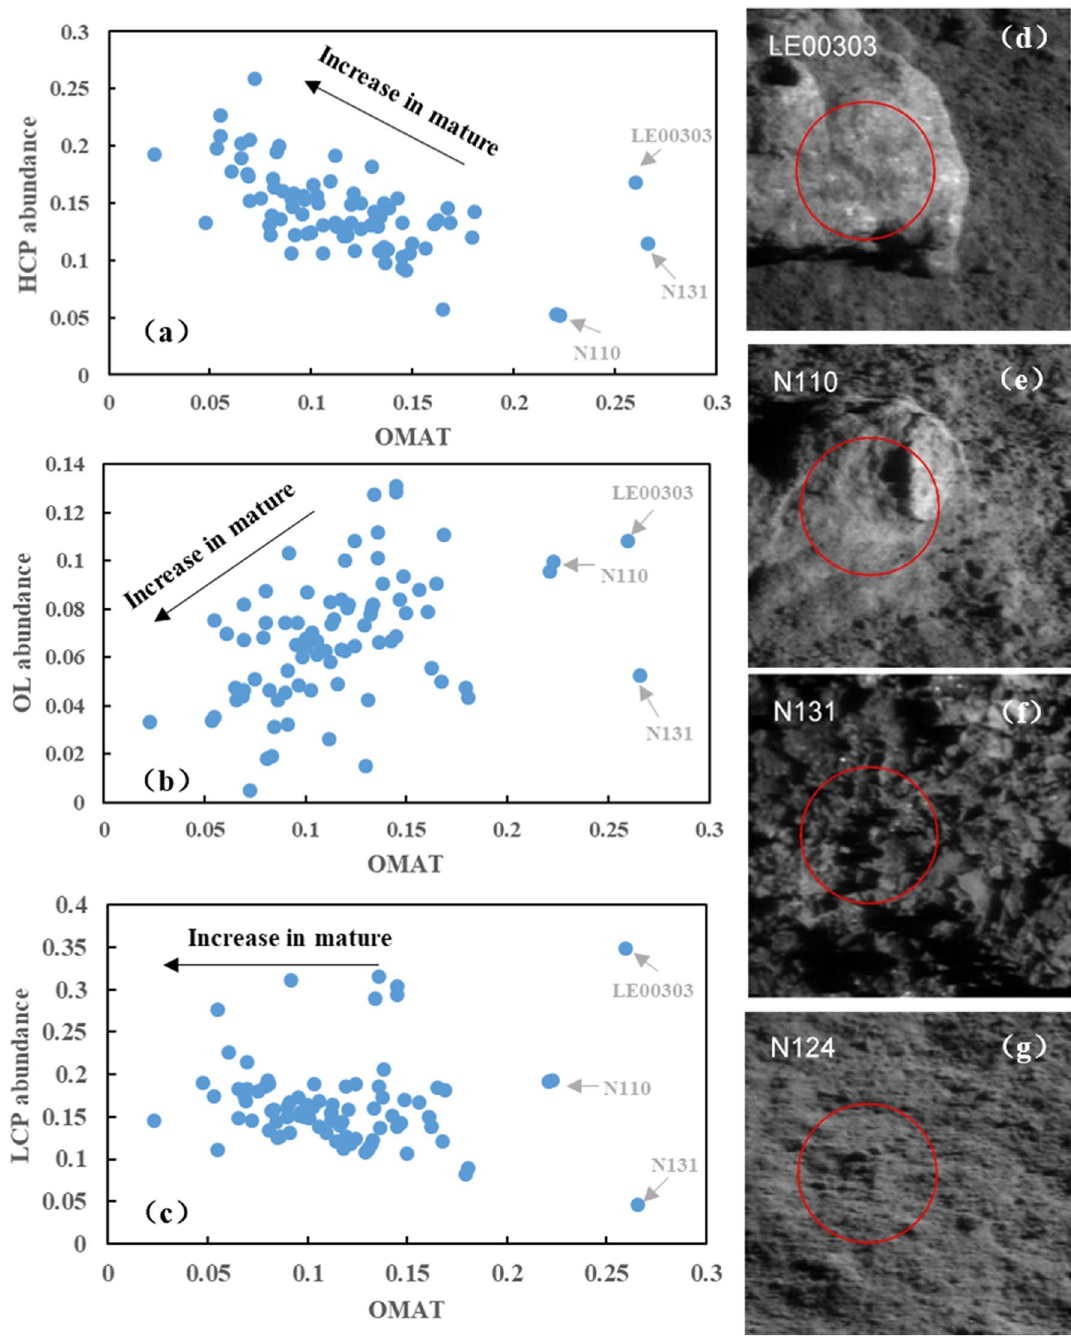
Figure 6. The relation between the OMAT and the main lunar minerals (HCP, LCP and OL). ( a – c ) are the scatterplots showing the relationship between the OMAT and the main lunar materials. ( d – g ) are the different type of lunar materials during the CE-4 routine path, ( d , e ) are the rock types, ( f ) is the fragment filled in the pit, ( g ) is the normal type of the lunar regolith nearby the Yutu-2, the red circle is the field of view (FOV) for SWIR. The VNIS images ( d – g ) were created by our own script in MATLAB 2013a (https:// www. mathw orks. com/ produ cts/ matlab.